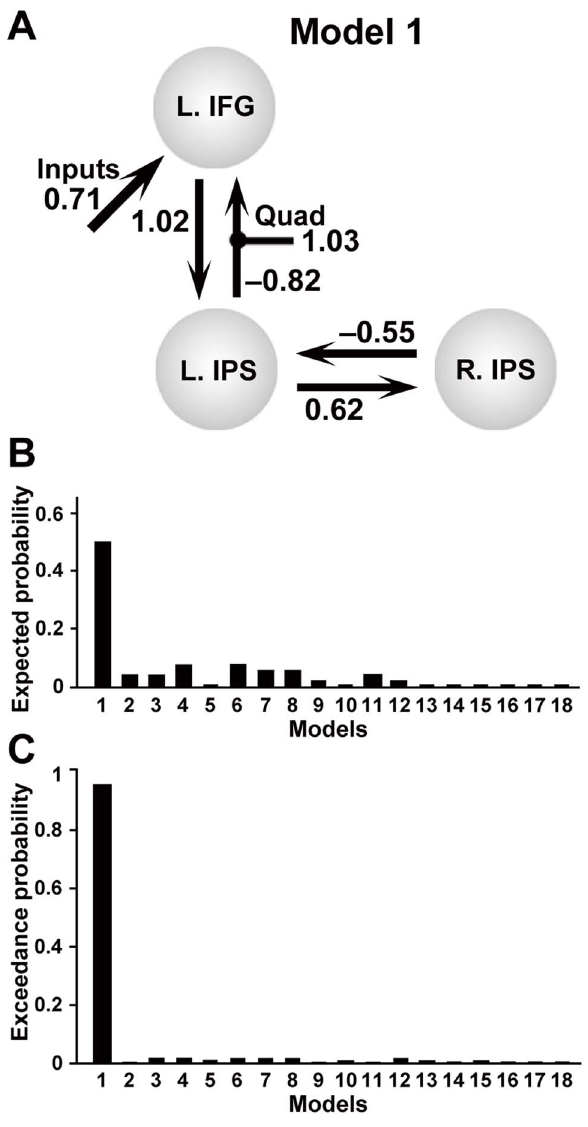
Figure 5. Effective connectivity among the L. IFG and bilateral IPS. (A) The best model with a positive modulatory effect for the bottom-up connection from the L. IPS to the L. IFG, and with driving inputs into the L. IFG. Mean parameter estimates that exceeded the statistical threshold (corrected P , 0.05) are indicated alongside the intrinsic connections. Bar graphs show expected probabilities (B) and exceedance probabilities (C) of all models tested (Figure S1).